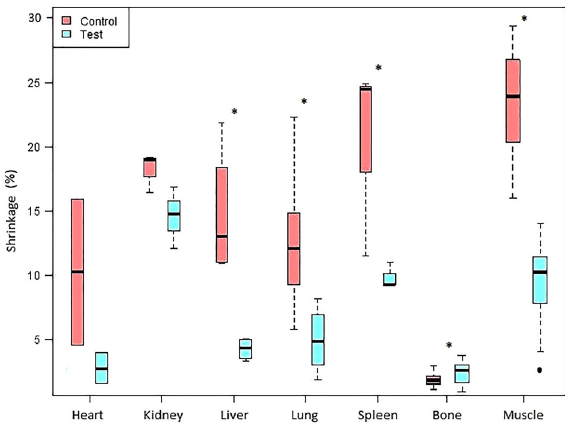
Figure 4. Comparison of percent shrinkage by biological tissues in the control (S10) and test (P1) groups. Data are reported as median and interquartile range. *P o 0.05 between groups (S10 and P1). (P o 0.05; Kruskal-Wallis